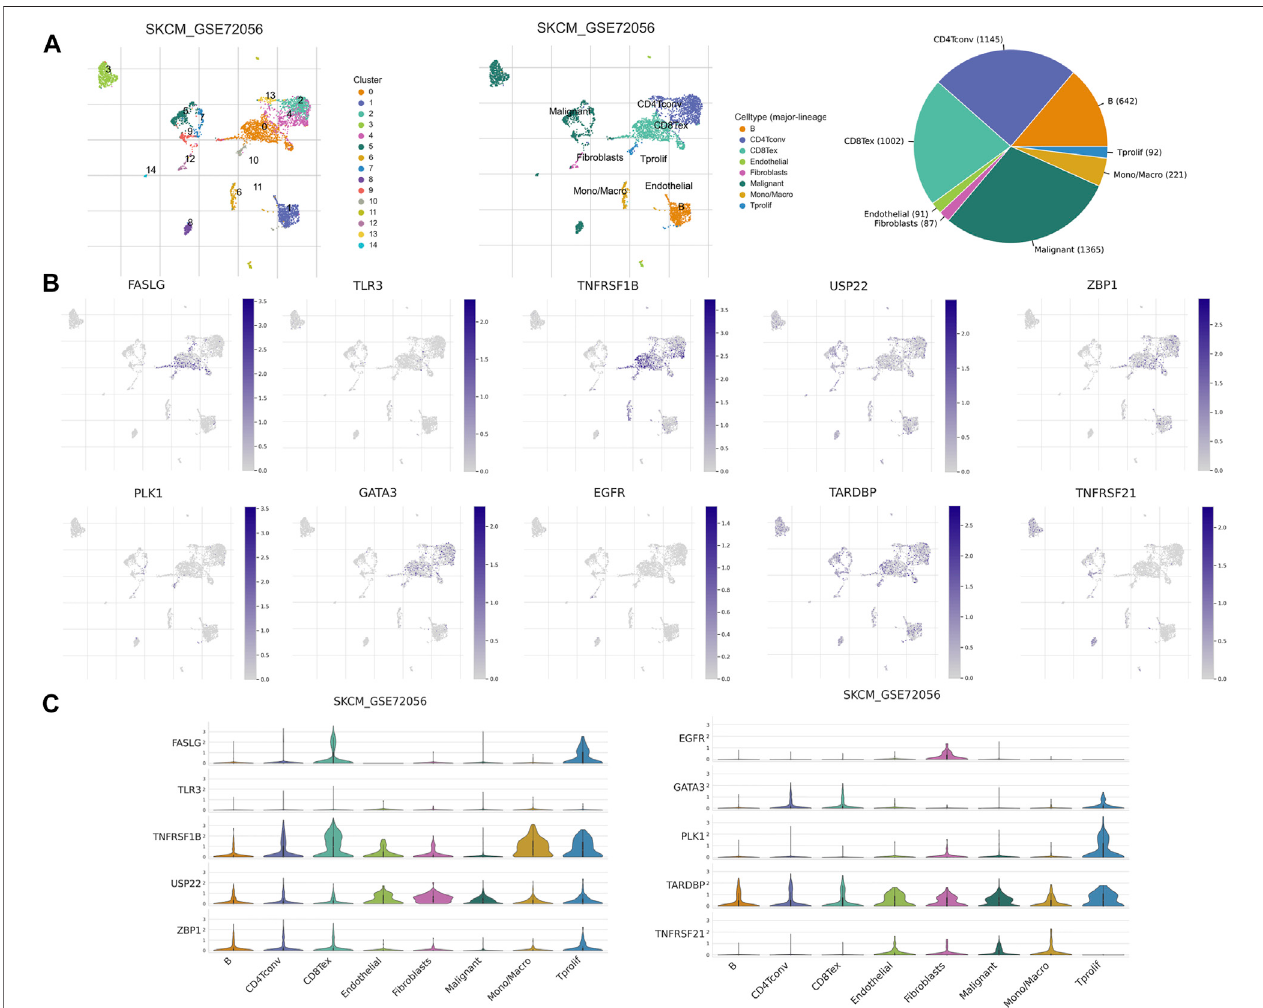
FIGURE10| NRGexpressioninSKCMTME-associatedcells. (A) AnnotationofallcelltypesinGSE72056andthepercentageofeachcelltype. (B,C) Percentages and expressions of FASLG, TLR3, TNFRSF1B, USP22, ZBP1, PLK1, GATA3, EGFR, TARDBP, and TNFRSF21 in different cell types in GSE72056.